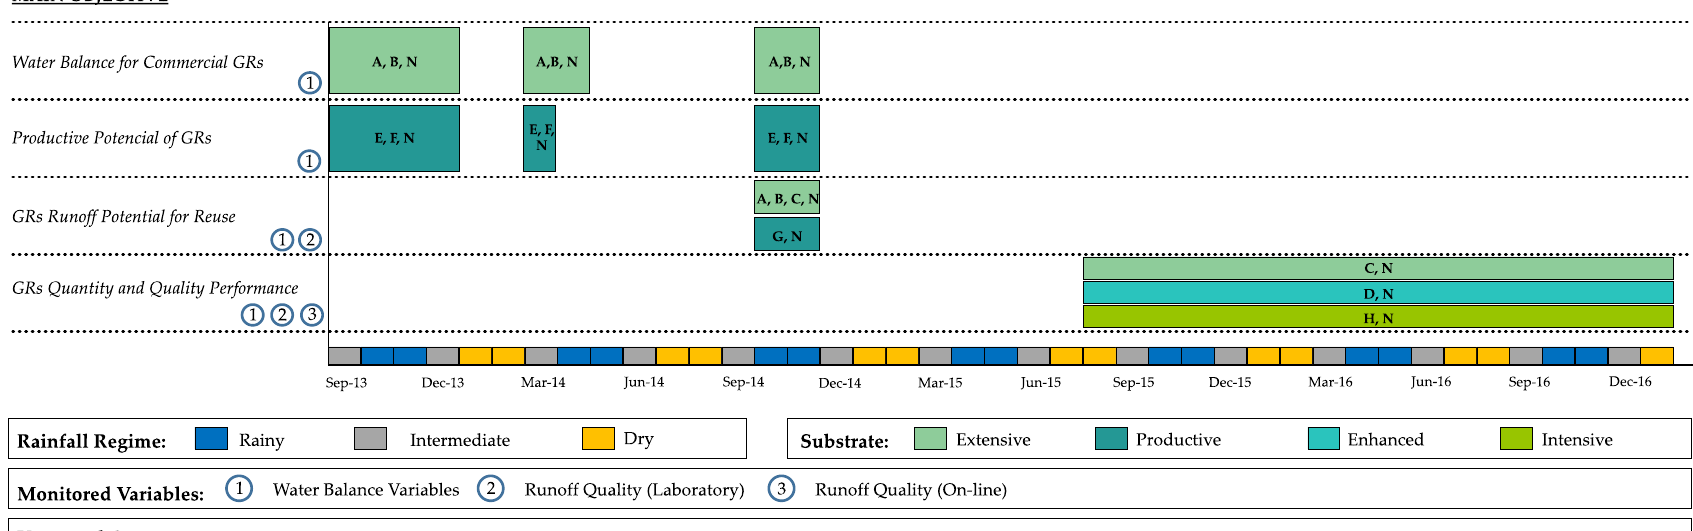
Figure 1. Experimental setup description. The Extensive Substrate has saturated hydraulic conductivity of 1.8 × 10 -7 m/s and apparent density of 421 kg/m 3 . The Enhanced Substrate has the following distribution on a dry basis: organic matter = 27.40%, total phosphorus = 3.47%, total Kjeldahl nitrogen (TKN) = 0.14%, and total suspended solids (TSS) = 63.20%. The Intensive Substrate has the following distribution on a dry basis: organic matter = 15.90%, total phosphorus = 3.22%, TKN = 0.14%, TSS = 76.30%. GR: green roof.